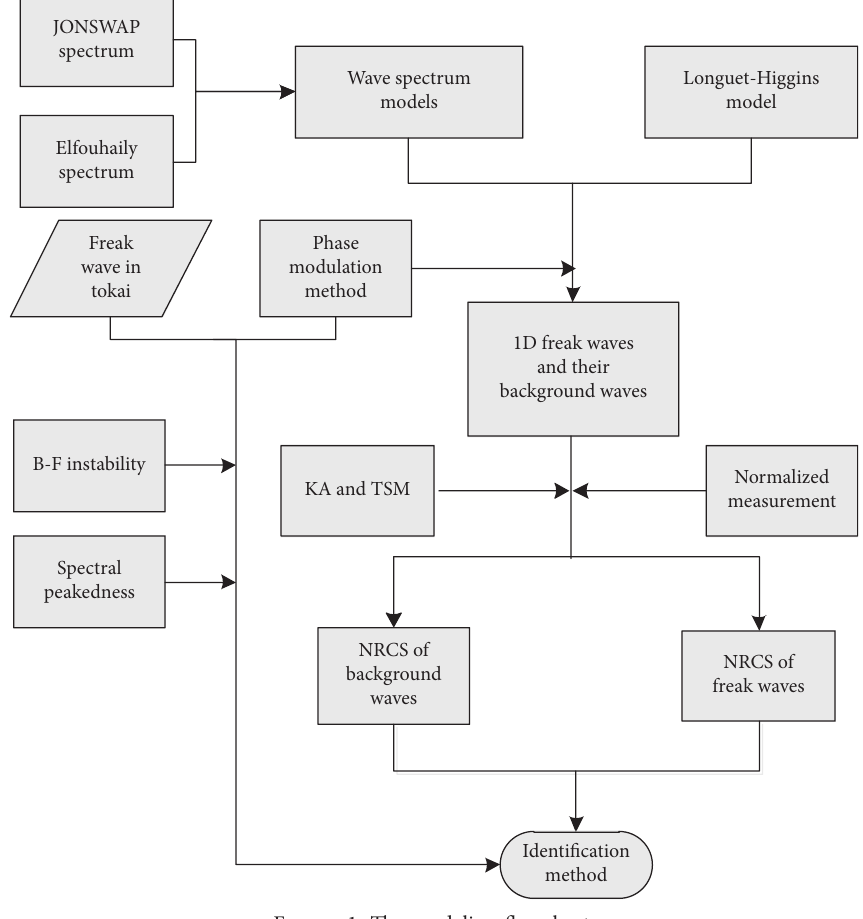
Figure 1: The modeling